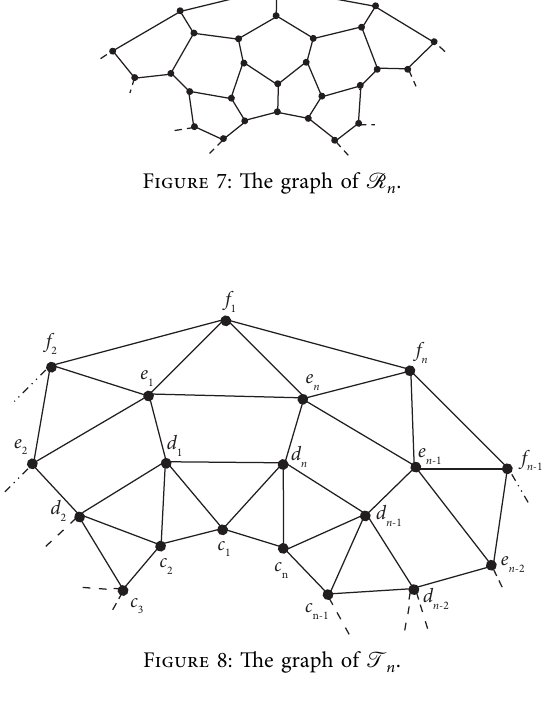
Table 3: Te table for graph of convex polytope T